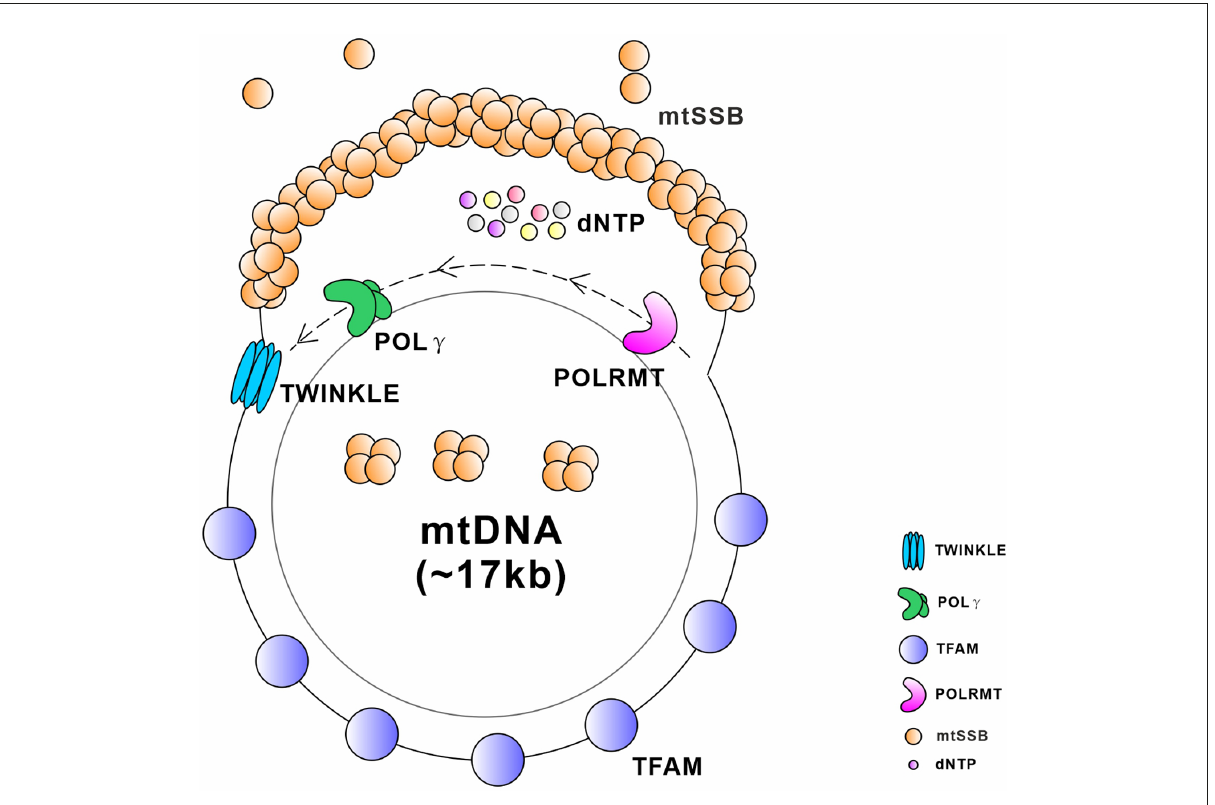
FIGURE5 Schematic diagram of critical proteins required for the replication and transcription of mtDNA. TWINKLE is an mtDNA helicase that catalyzes the unwinding of duplex DNA using energy from NTP hydrolysis. Mitochondrial single stranded DNA-binding protein (mtSSB) exists as a stable tetramer and binds single-stranded DNA intermediates that form transiently during genome maintenance. DNA polymerase gamma (POL γ ) is a DNA polymerase that synthesizes a nascent strand using one of the unwound parental template strands at the replication fork. Mitochondrial transcription factor A (TFAM) is a master regulator of mitochondrial transcription initiation and mtDNA replication that binds the promoter region of mtDNA in a sequence-specific manner and thereby initiates promoter-specific transcription or replication from the light-strand